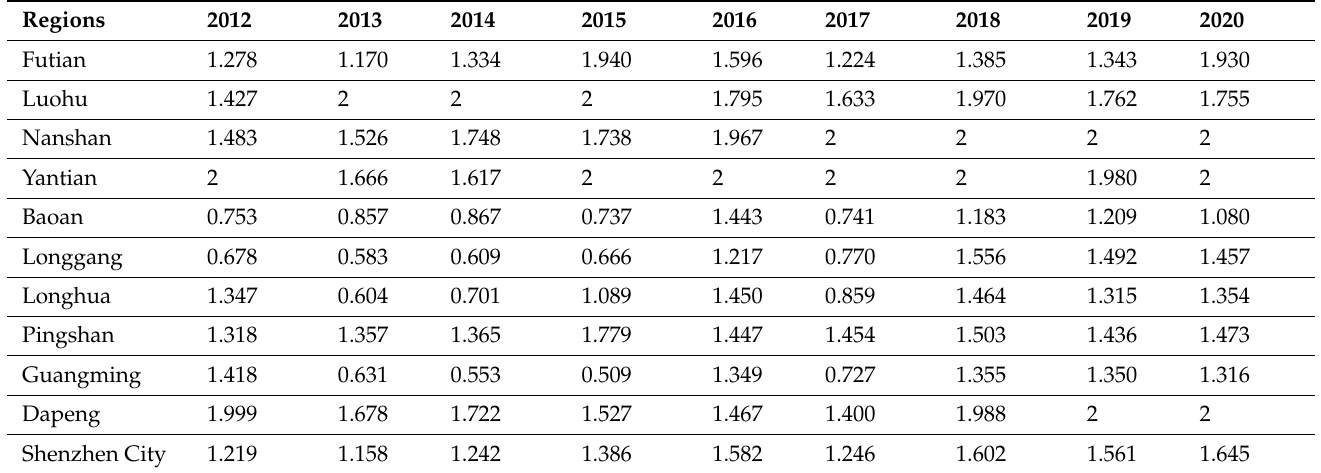
Figure 3. The temporal and spatial characteristics of regional coupling FEW efficiencies across the districts within Shenzhen City. Table 4. Values for coupling FEW efficiency levels of Shenzhen City from 2012 to